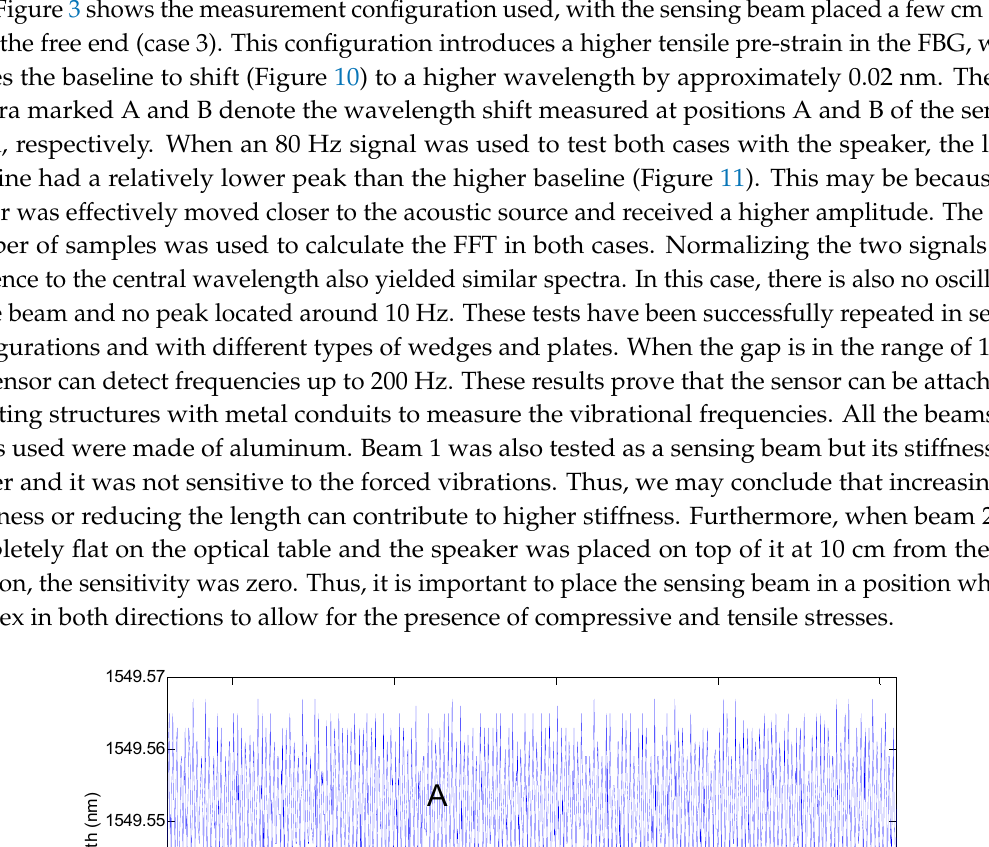
Figure 9. FFT data of negligible cantilever vibrations with a dominant peak at 150 Hz due to the phone.